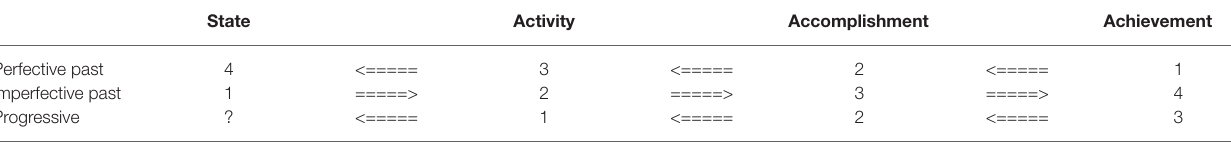
TABLE 1 | Predicted order of development of tense-aspect morphology (adapted from Li and Shirai, 2000, p.